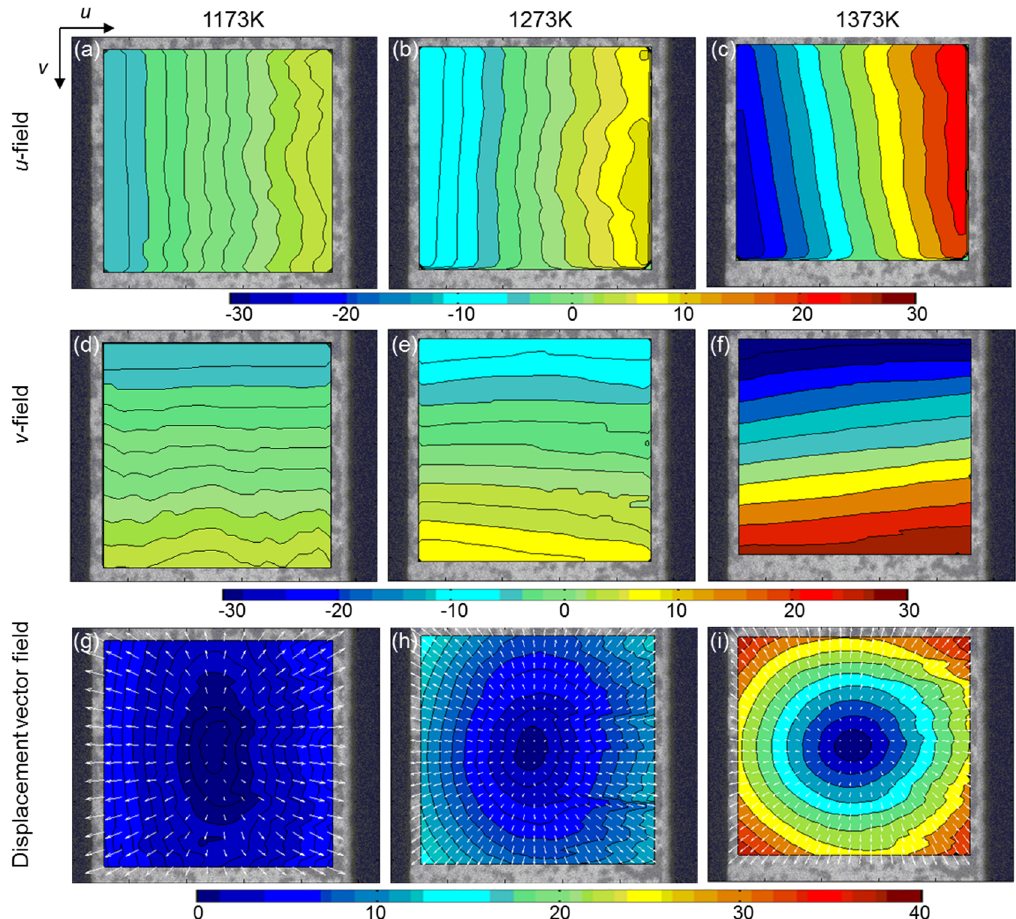
Figure 13. u , v displacement fields and displacements vector fields measured at 1173 K, 1273 K and 1373 K after removing rigid-body rotation.